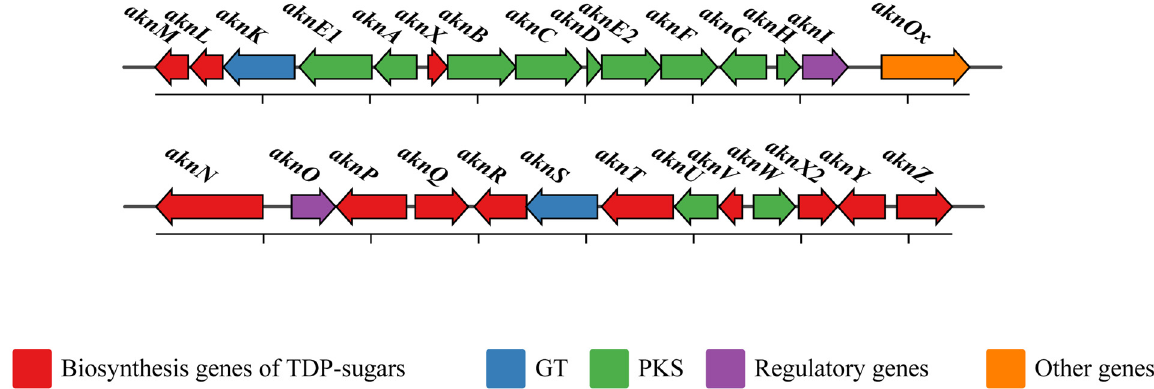
Figure 2. Organization of the aclacinomycins biosynthesis gene cluster. Arrows indicate the directions of gene transcription. GT, glycosyltransferase; PKS, polyketide synthase.